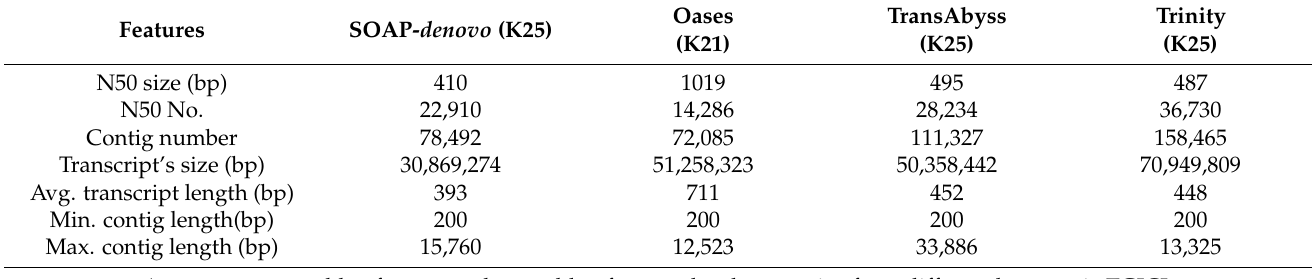
Table 3. Comparison of denovo transcriptome assembly results for four different assembly software: SOAP- denovo , Oases, TransAbyss, and